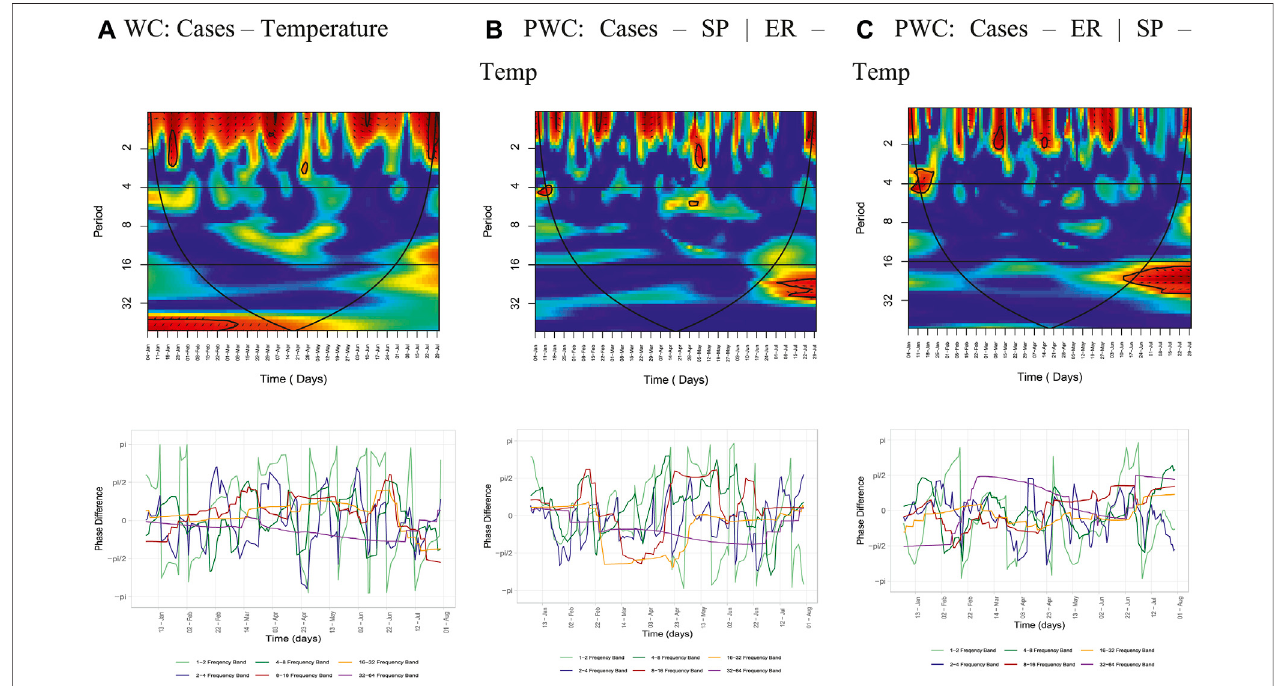
FIGURE 5 | Germany. (A) WC: Cases — Temperature. (B) PWC: Cases — SP | ER — Temp. (C) PWC: Cases — ER | SP —